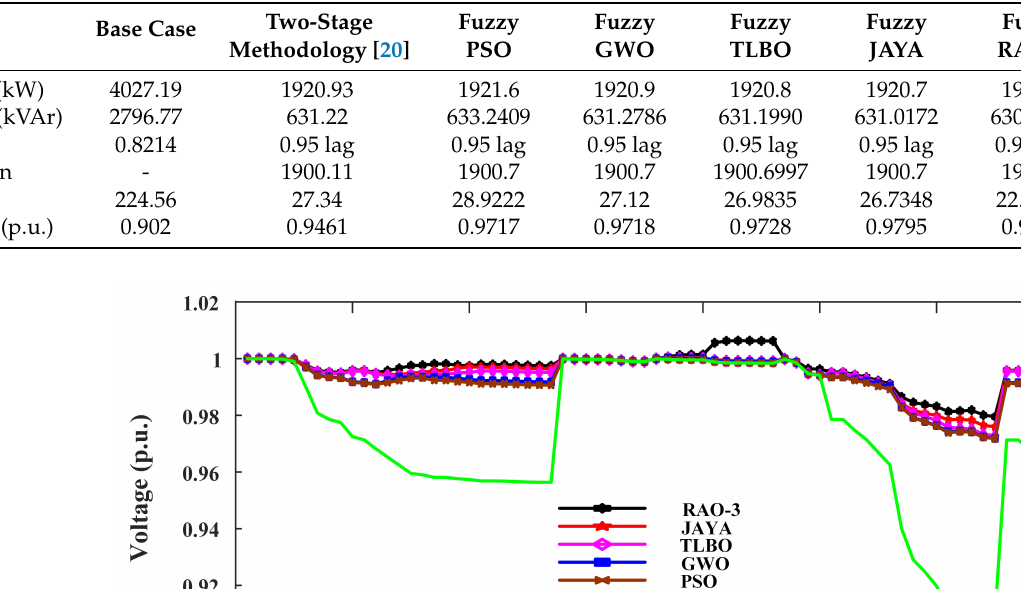
Table 4. Performance comparison of the 69-bus system.